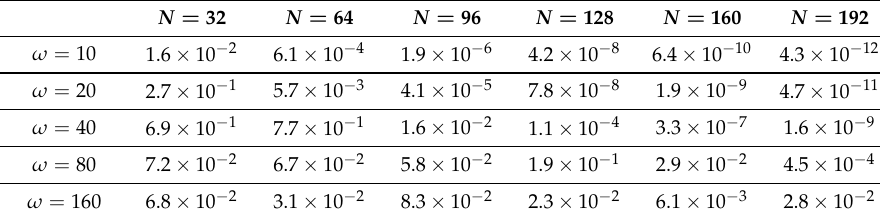
Table 8. Absolute errors of 2D-d for Example 3.